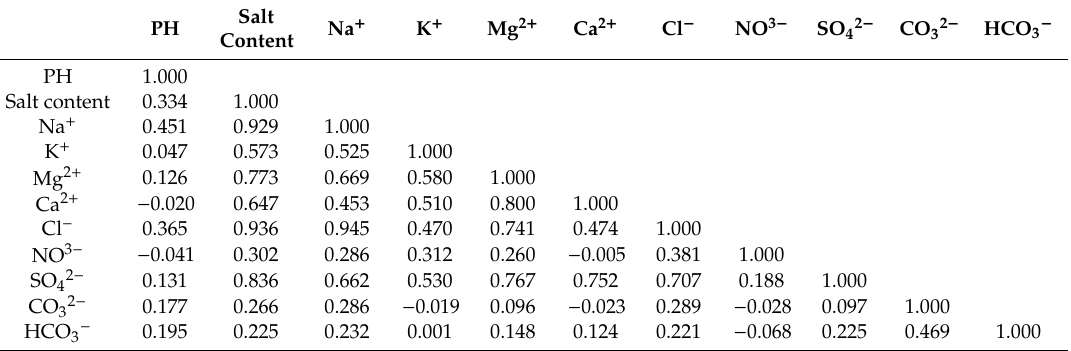
Table 3. Spearman rank correlation coefficients between measured soil variables.